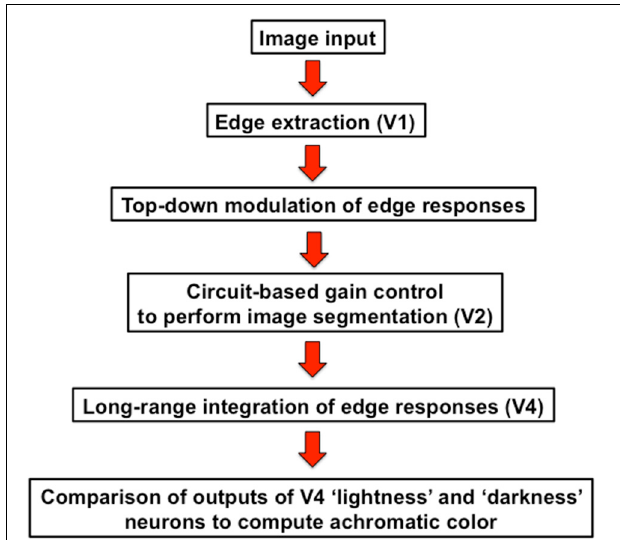
FIGURE 1 | Cortical stages of lightness computation in the neural edge integration